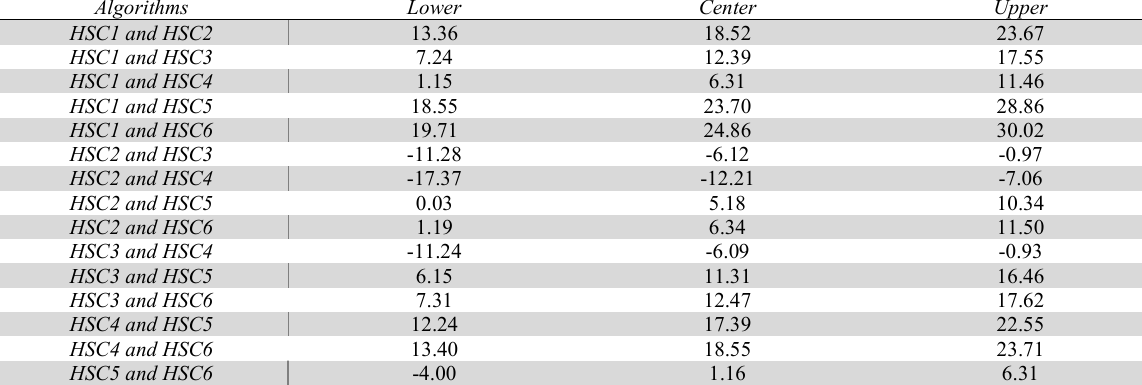
Fisher 90% Individual confidence intervals all pairwise comparisons